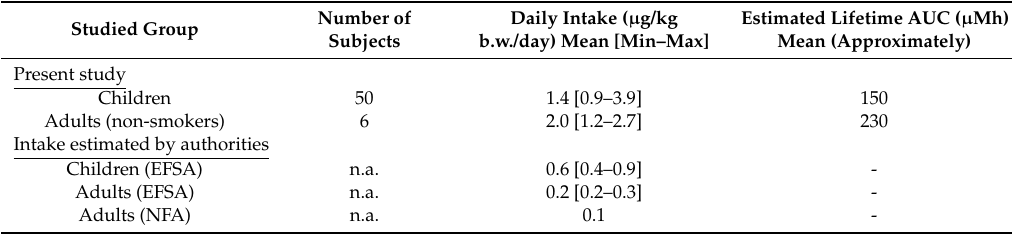
Table 3. Estimated daily intakes of glycidol and calculated AUC at corresponding estimated lifetime exposures of glycidol, calculated from Hb adduct levels measured in children and adults (non-smokers) in the present study. Daily intakes estimated from dietary patterns by the European Food Safety Authority (EFSA) and the Swedish National Food Agency (NFA) are used for comparison